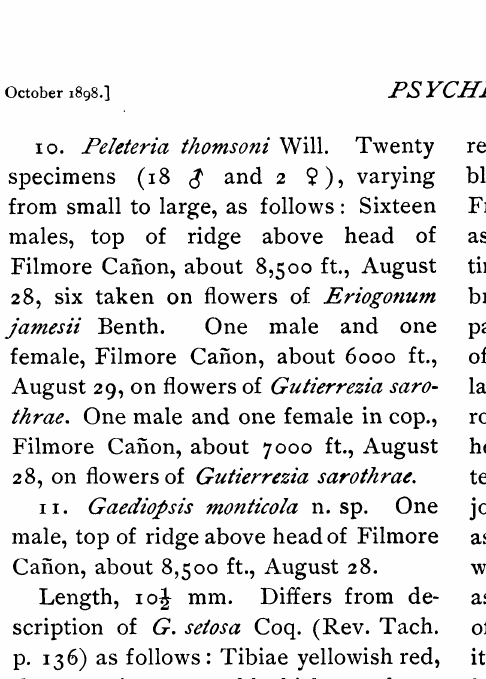
Fig. 3 x. Acridiura rubiginosum. Harris